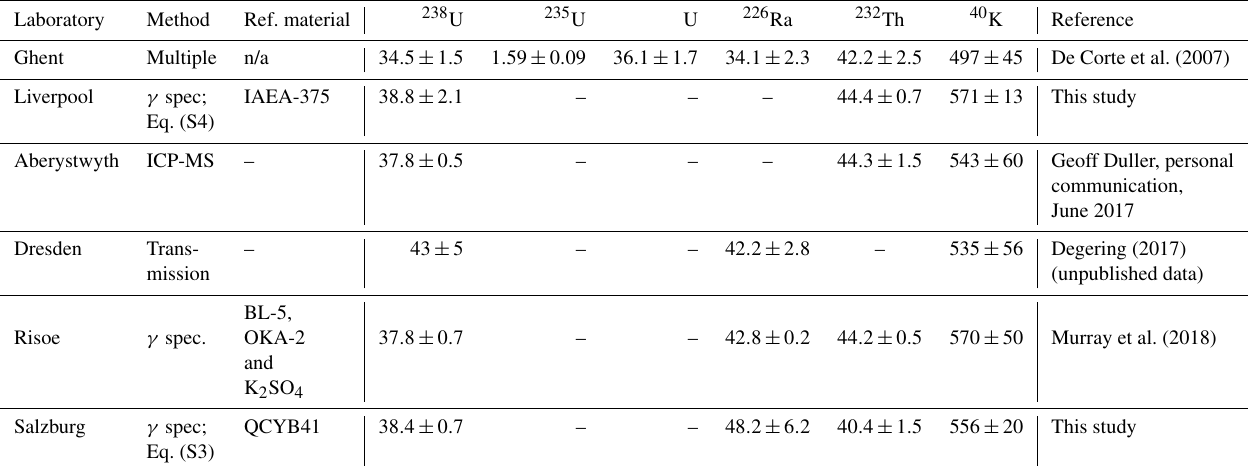
Table C1. The Volkegem loess: activity concentrations (Bqkg − 1 ) determined in different laboratories using different methods.